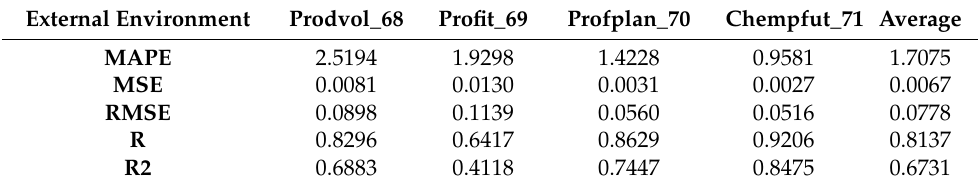
Table 12. Testing results for the effect of the external environment on firm performance.